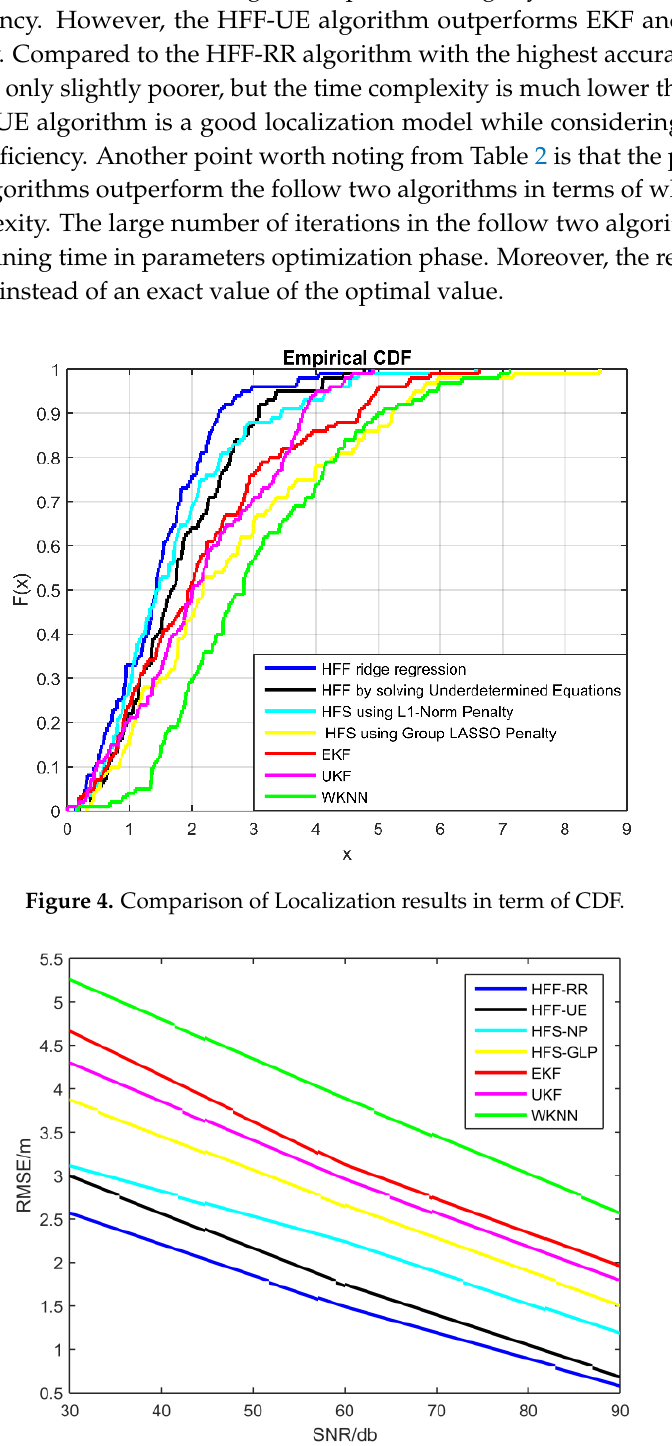
Figure 5. Root Mean Square Error (RMSE) as Signal Noise Ratio (SNR). Table 2. Estimation error and computation complexity for different algorithms under TOA & RSS noise conditions.